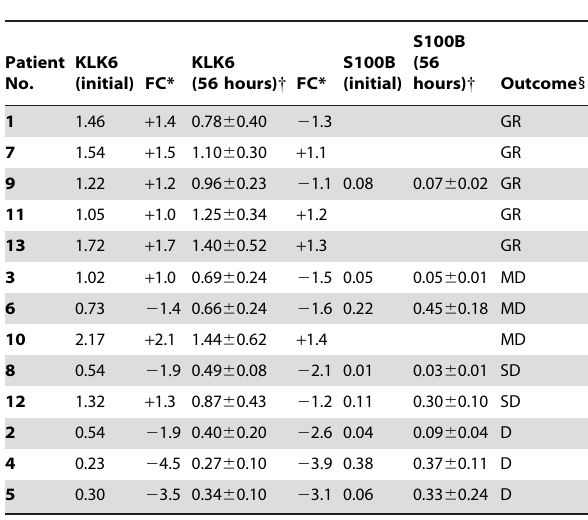
Table 1. Serum concentrations of KLK6 and S100B (ng/mL) in the initial sample and all samples collected within the first 56 hours from patients with subarachnoid hemorrhage.